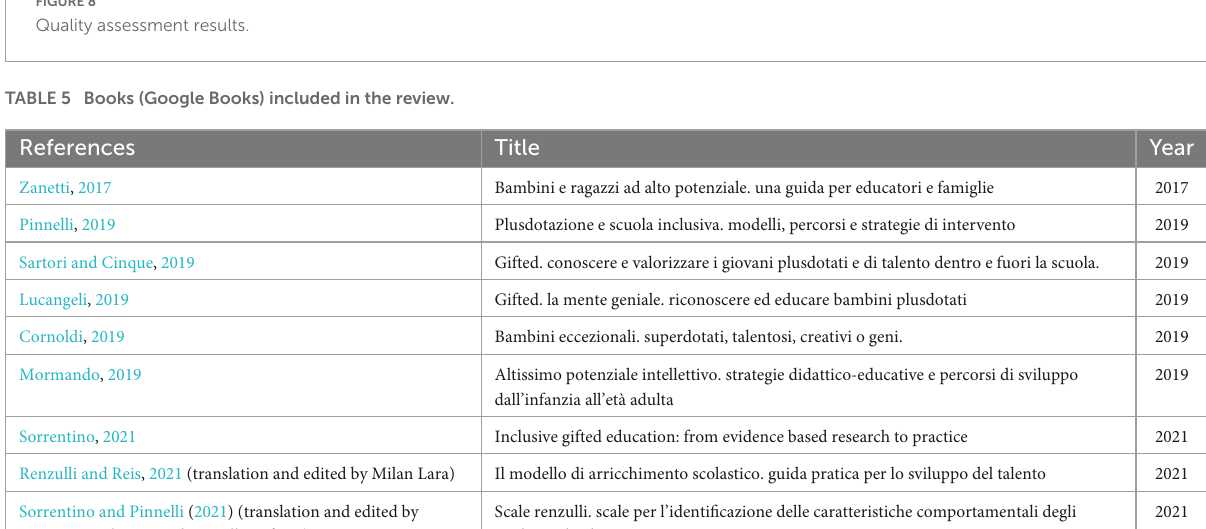
FIGURE8 Quality assessment